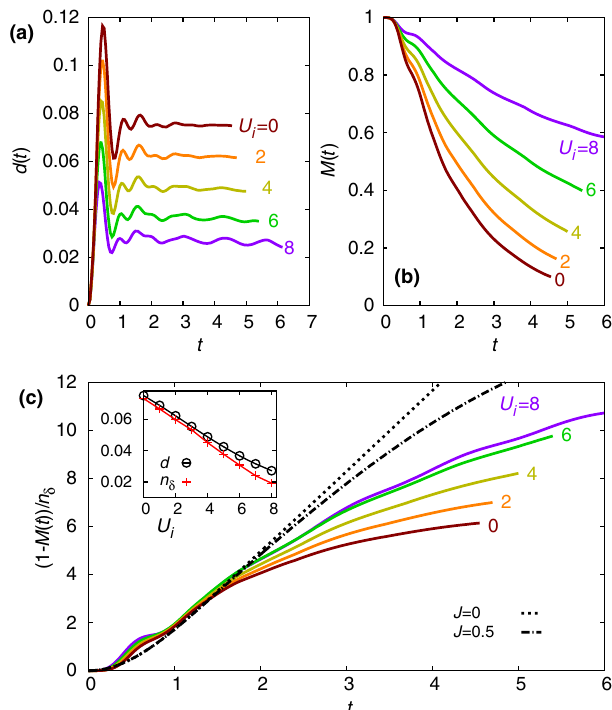
FIG. 5. Data for the following quench protocol: t < 0 : J ¼ 0 (cid:2) (Néel state); 0 ≤ t < 0 . 5 : J ¼ 1 , U ¼ U i ; t ≥ 0 . 5 : J ¼ 1 , (cid:2) (cid:2) U ¼ 8 . The intermediate step controls the excitation density in the final state. (a) Time evolution of the double occupancy or various values of U i . (b) Time evolution of the order parameter M ð t Þ . (c) Number of spin flips per charge-carrier density n δ , ½ 1 − M ð t Þ(cid:4) =n δ , compared to the mean displacement R ð t Þ of 0 the initially localized particle in the t - J z model for J (cid:2) ex ¼ 0 . 5 (dotted and dashed black lines; see text). The inset and J (cid:2) ex ¼ shows the average of d ð t Þ for 2 ≤ t ≤ 5 (open circles), and the density of mobile carriers n δ , obtained from the integrated weight in the upper Hubbard band (red